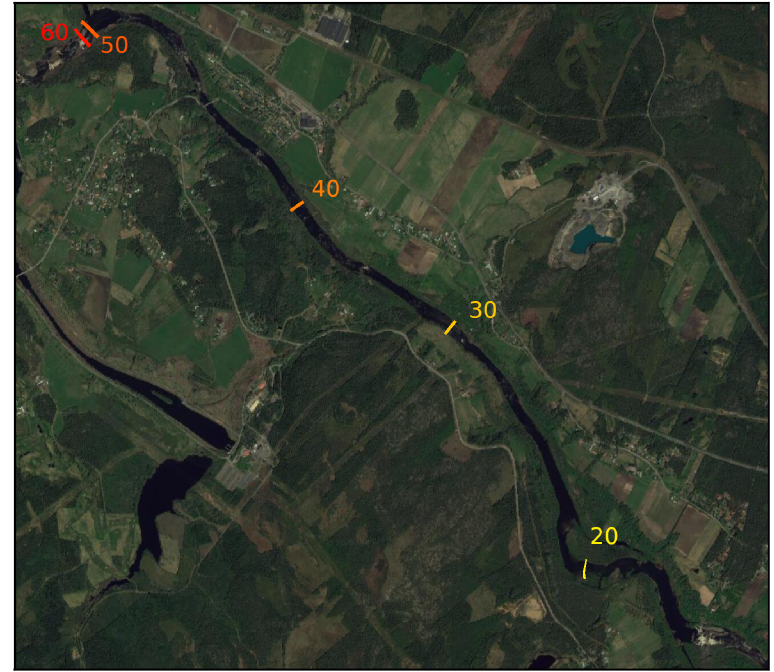
Figure 11. Cross-section corresponding to the most upstream observation of continuous dynamics for the five different scenarios where it occurs. The legend is in flow changes per